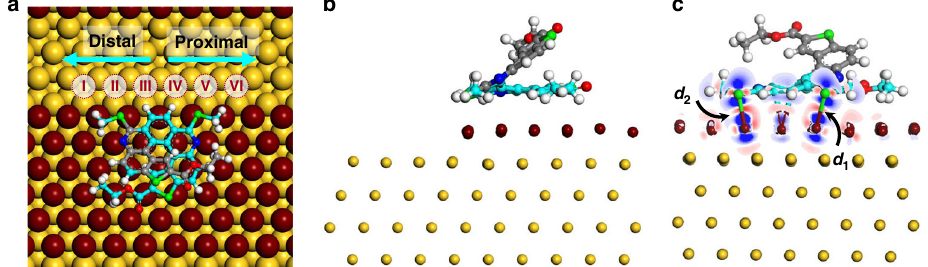
Fig. 6 Chemical bonding at the step. a Top, b side and c front views of the adsorption geometry of a helicene at the B-step. I – VI are the different locations considered for the evaluation of adatom attachment. Electron-density difference is applied in c to illustrate the chemical bonding between helicene and step. Charge depletion and charge accumulation are displayed in blue and in red with a contour value of 0.03 e Å – 3 , respectively. The two Au-S bonds are indicated by d 1 (2.728 Å) and d 2 (2.575 Å), respectively